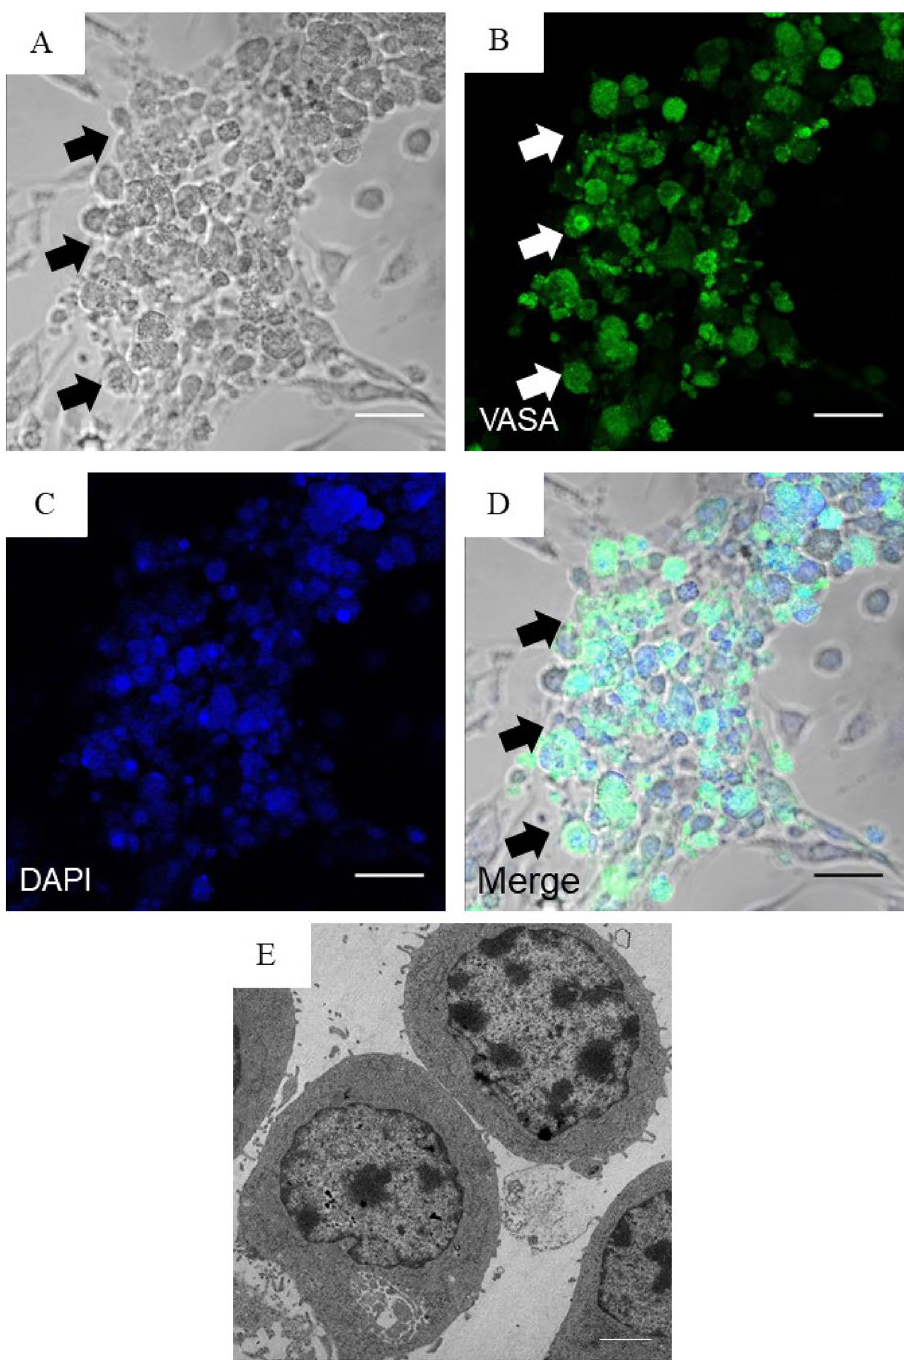
Figure 3. Bright-field images of testicular cells from infertile humans in vitro. Testicular cells from human cases after expansion in culture: ( A ) Infertile human testicular cell expansion in culture, ( B ) Immunohistochemical analysis of VASA in human cells, ( C ) DAPI, ( D ) merge of DAPI and VASA, and ( E ) electron microscopy image representing cell features and the various diameters of the nucleus of infertility human SSCs in vitro. Scale bar ( A – D ) (25 μm) and ( E ) (2